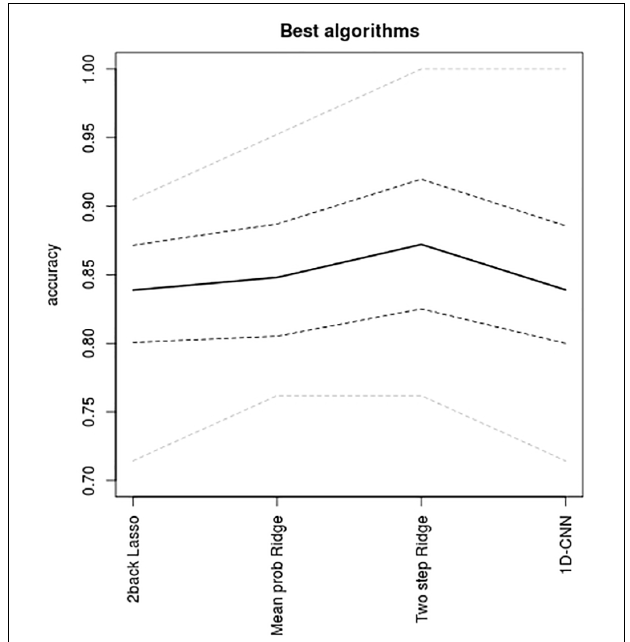
FIGURE 5 | Images showing, for each pair of brain maps, the degree of overlap between voxels selected in the first step of the sequential Ridge algorithm. Percentages of overlap are given for each pair. Chance overlap under a scenario of complete spatial independence is 4%. remaining pairs had values near 20%. Although this is clearly